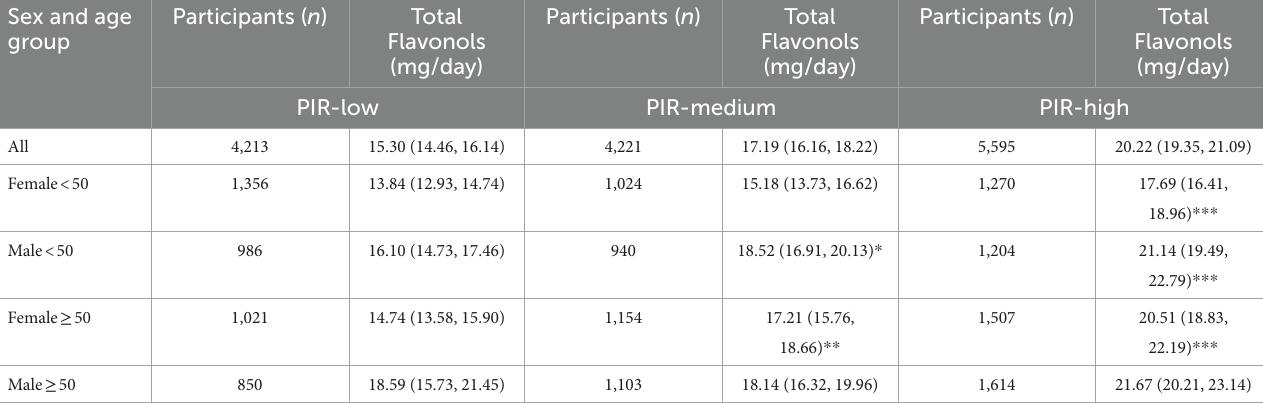
TABLE 2 Mean intake of total flavonols by age, sex, and PIR